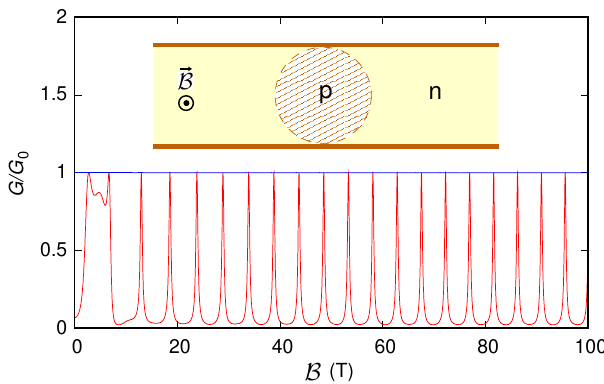
Figure 11. Conductance G , normalized with respect to the conductance quantum G 0 , which was obtained as a function of the orthogonal magnetic field B for the ribbon (with length 120 nm and width ∼ 36 nm) represented in the inset, where the presence of a Lorentzian-shaped potential introduces a circular p – n junction. The red curve indicates a semiconducting ribbon, while the blue line indicates a metallic